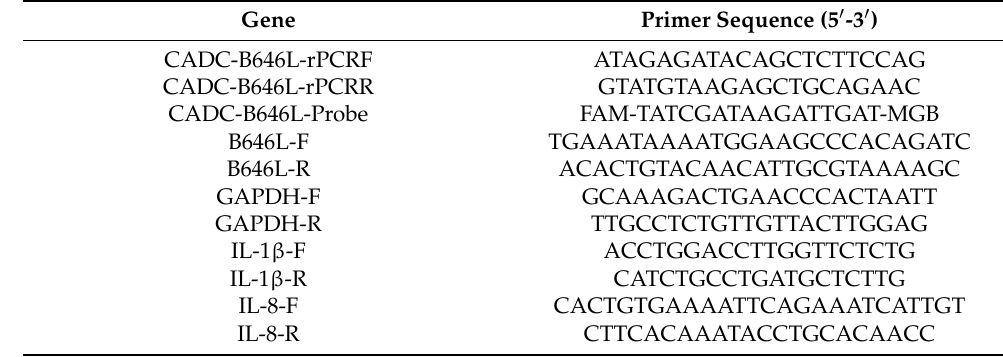
Table 1. Primer sequences used in this study for PCR and real-time PCR in pigs. Gene Primer Sequence (5 (cid:48) -3 (cid:48) )